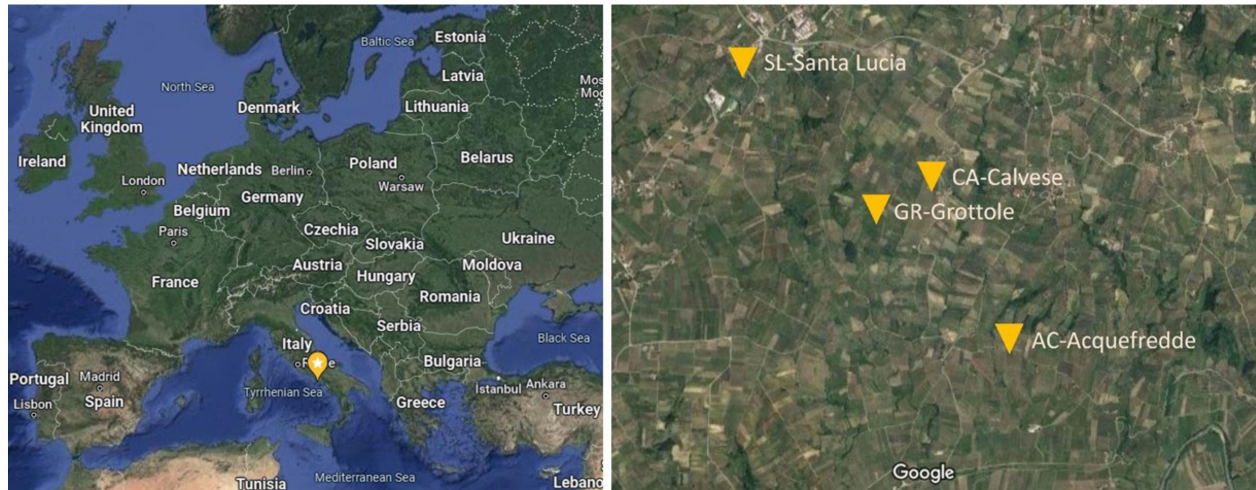
Figure 1. Location of the four selected vineyards: SL-Santa Lucia (41 ◦ 14 (cid:48) 45 (cid:48)(cid:48) N, 14 ◦ 34 (cid:48) 16 (cid:48)(cid:48) E, 194 m above sea level—a.s.l.), CA-Calvese (41 ◦ 14 (cid:48) 19 (cid:48)(cid:48) N, 14 ◦ 35 (cid:48) 11 (cid:48)(cid:48) E, 163 m a.s.l.), GR-Grottole (41 ◦ 14 (cid:48) 21 (cid:48)(cid:48) N, 14 ◦ 34 (cid:48) 56 (cid:48)(cid:48) E, 158 m a.s.l.), AC-Acquefredde (41 ◦ 13 (cid:48) 44 (cid:48)(cid:48) N, 14 ◦ 35 (cid:48) 33 (cid:48)(cid:48) E, 84 m a.s.l.). Source: Google Earth